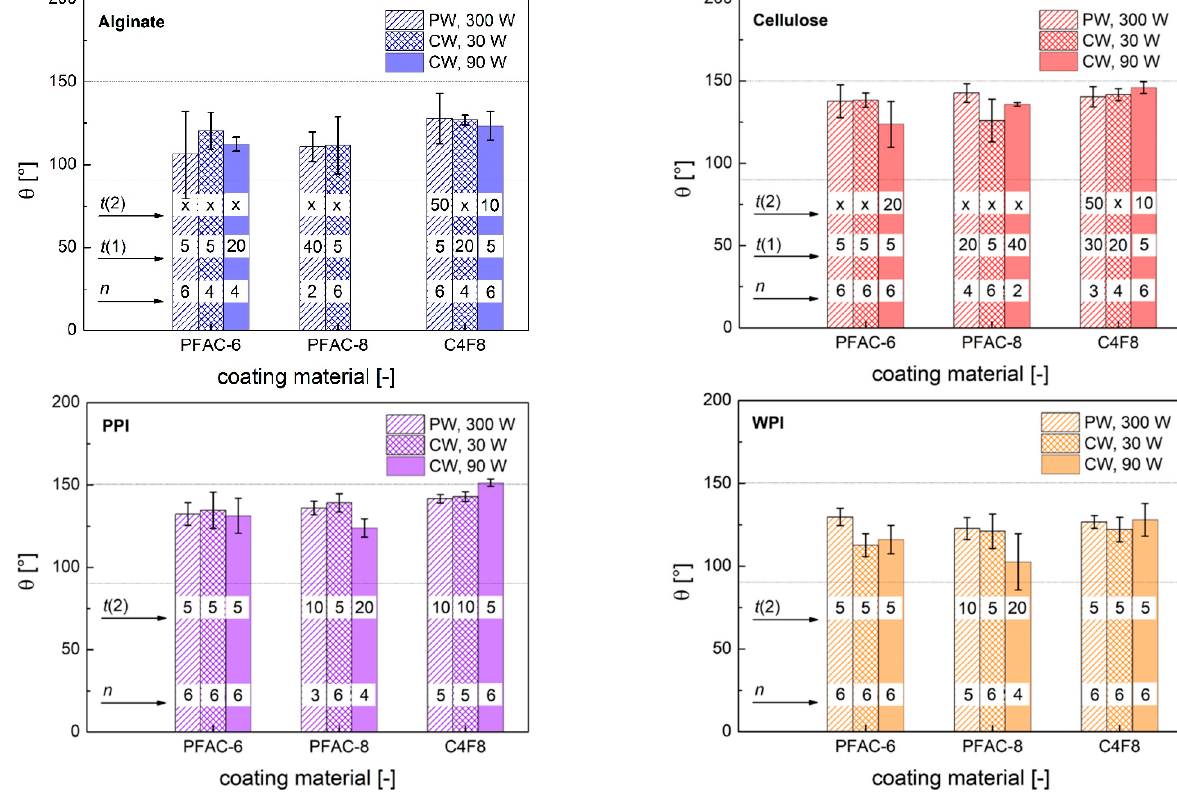
Figure 2. Static water contact angles θ depending on coating material and aerogel type. Dashed lines mark the regions of hydrophobicity ( θ = 90–150°) to superhydrophobicity ( θ ≥ 150°). All values represent the average of successful settings n (cases 3 and 4) at different process times; error bars represent the standard deviation of the averaged values. PW (pulsed wave mode) and CW (continuous wave mode) stand for the power input mode; accordingly, numbers represent the input energy. Numbers in columns stand for the minimum process times (min) needed to achieve the corresponding case; x denotes that the corresponding case did not occur under the given process conditions. Table 4. Range of static water contact angles on different aerogel substrates.